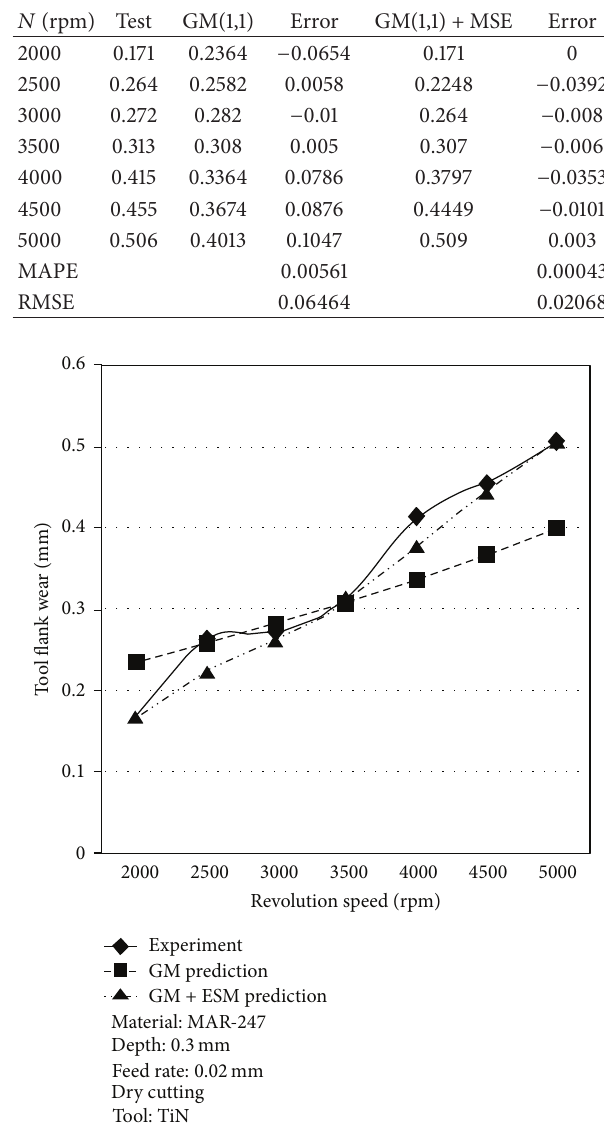
Figure 7: Relationships between revolution speed of main shaft and tool wear